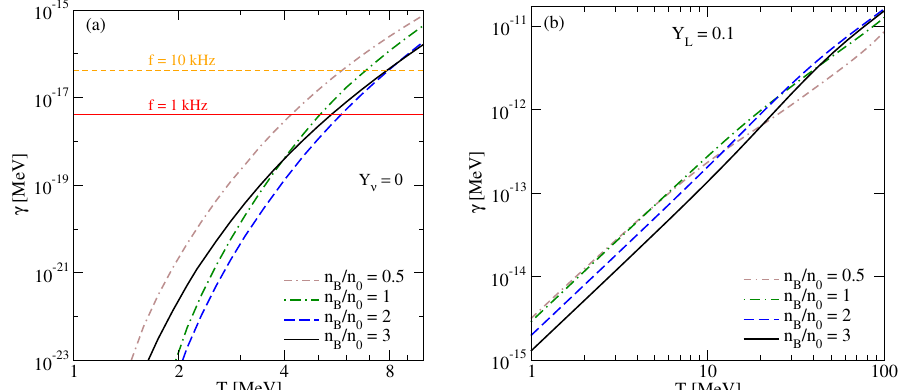
Figure 3. The beta-relaxation rate γ as a function of the temperature for ( a ) neutrino-transparent and ( b ) neutrino-trapped regimes for several values of baryon density. Note the very different y -axis scales. The horizontal lines in panel ( a ) correspond to the fixed values of oscillation frequency f = 1 kHz (solid line) and f = 10 kHz (dashed